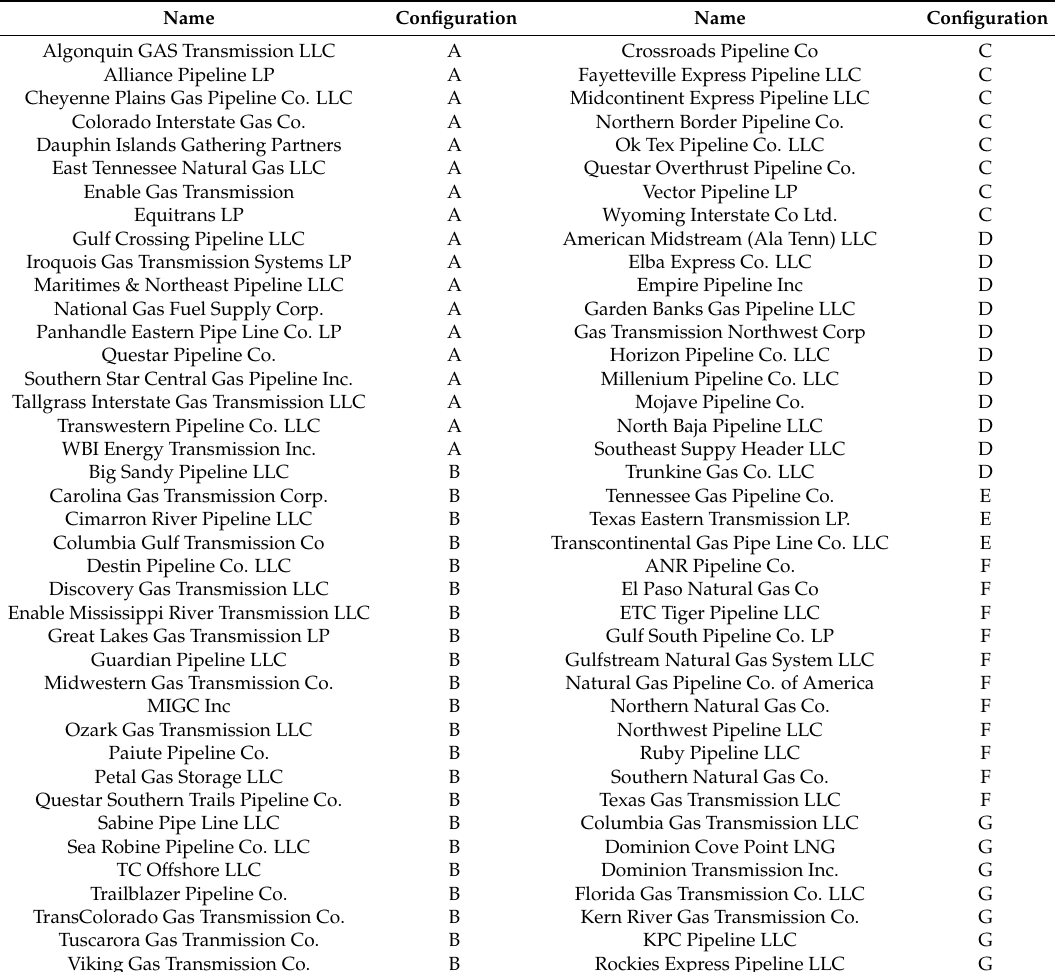
Table A1. List of natural gas infrastructure systems grouped by